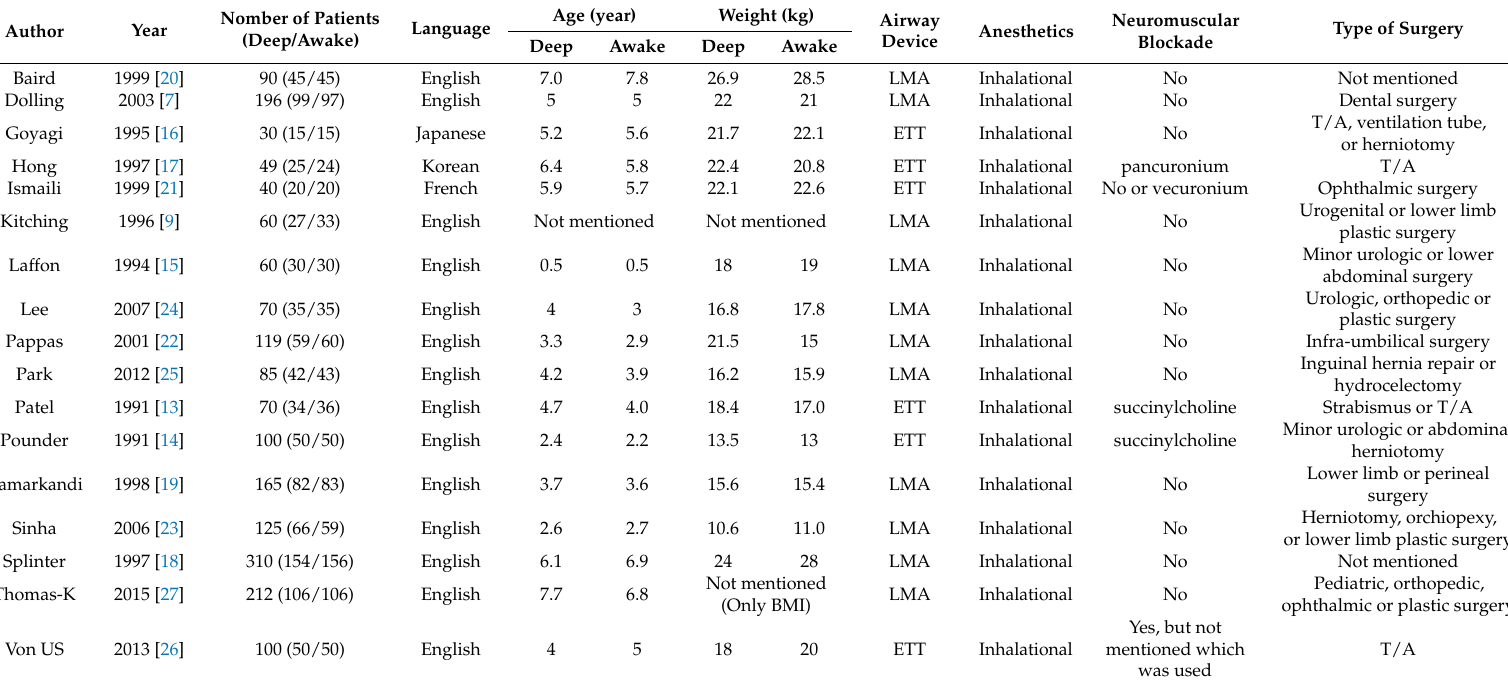
Table 1. Baseline charactersitics and population of the included randomized trials ( n =